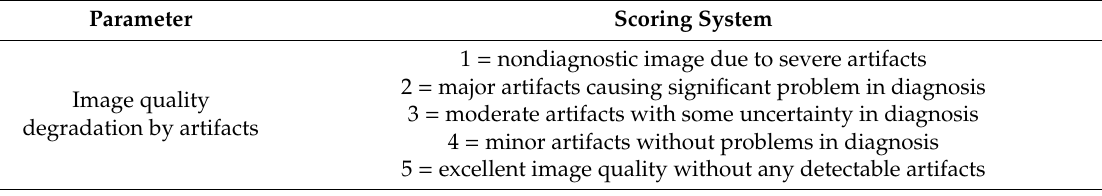
Table 1. Image quality parameter